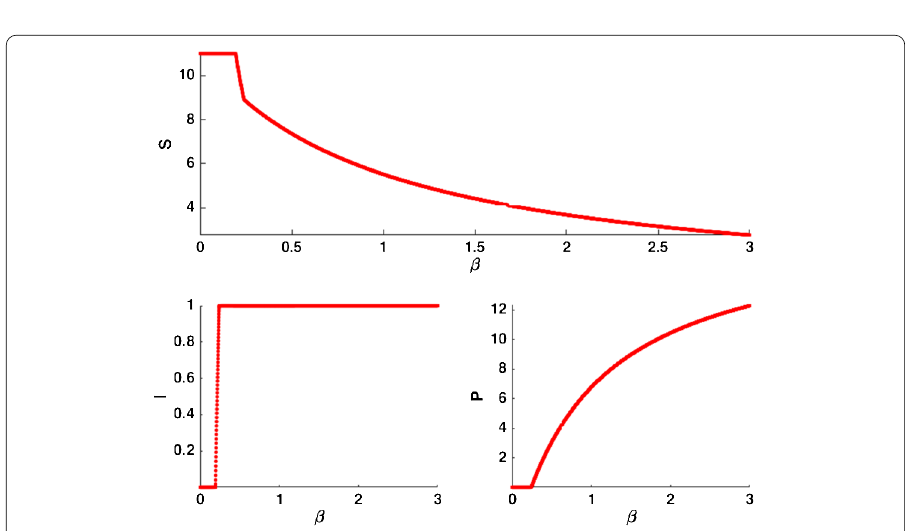
Figure 5 Bifurcation diagram of the fractional-order model (3) with respect to prey’s disease ( β ) when q = 0.95